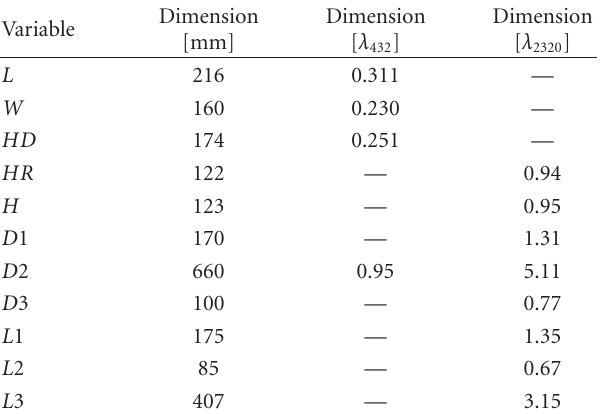
Table 1: Main design dimensions of the proposed prime-focus.